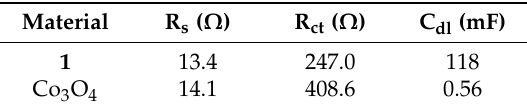
Table 4. Summary of fitted EIS data for 1 and Co 3 O 4 .